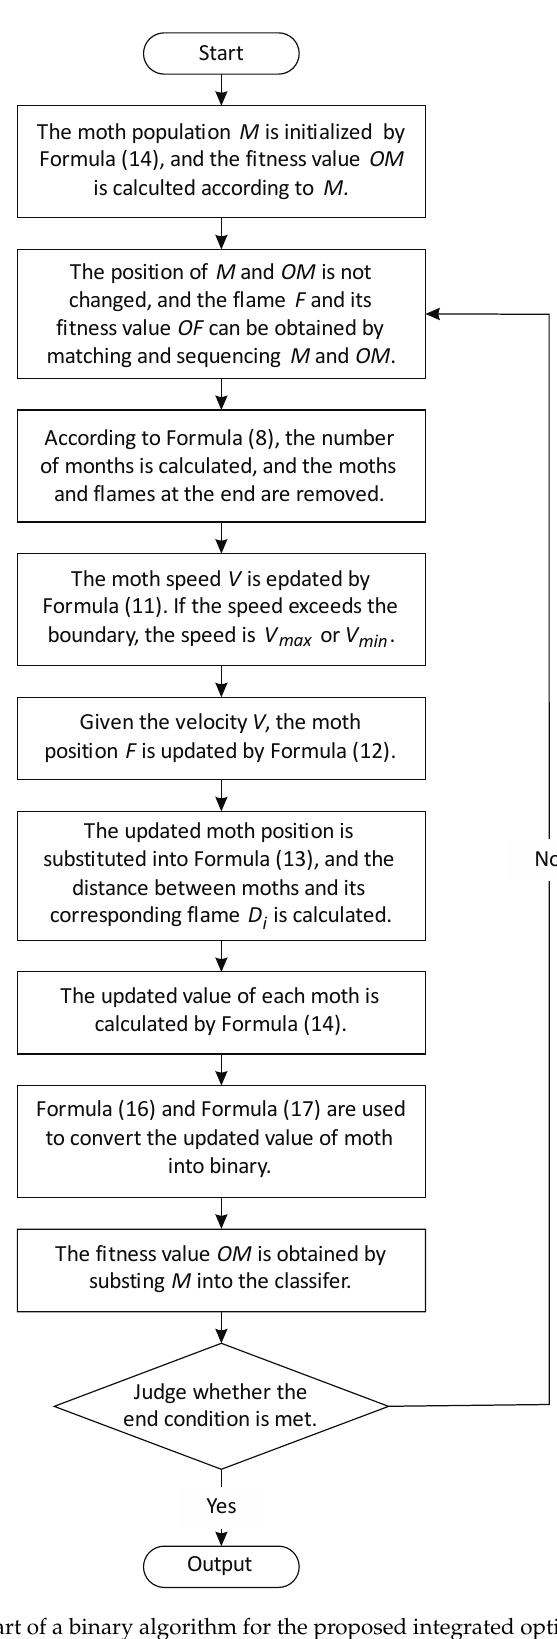
Figure 2. Flow chart of a binary algorithm for the proposed integrated optimization algorithm.